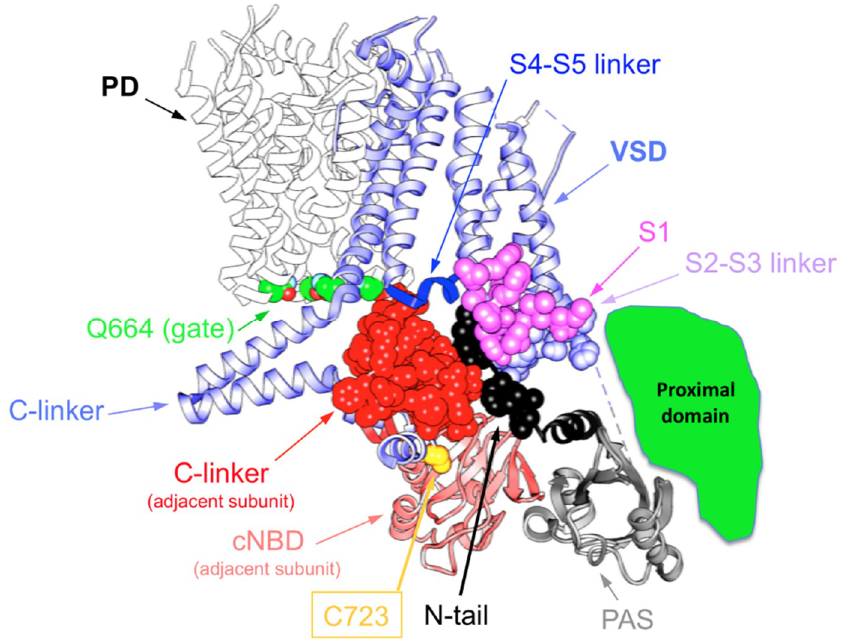
Figure 5. Extensive network of interactions between Kv11.1 (hERG; PDB: 5VA2) cytoplasmic domains involving several N- and C-terminal regions, plus the S4–S5, S2–S3 and C-linkers, that may dynamically contribute to modulate channel gating. A single VSD is only shown attached to the tetramer of the PD for clarity. The four residues Q664 that mark the place of the cytoplasmic gate at the S6 helix bundle are signaled. Atoms corresponding to the amino terminal N-tail (black), the S2–S3 linker (blue) and the S1 C-terminus of the same subunit (magenta), and the C-linker of the adjacent subunit (red), are shown as spheres. The positions of the PAS domain (grey), the S4–S5 linker (dark blue) and the C-linker of the same subunit, but also the cNBD of the adjacent subunit, are also signaled. Note the position of endogenous cysteine 723, known to establish disulfide bridges with cysteines engineered at the initial residues of the N-tail under different conditions [140,141]. The lower right green area indicates the approximate and speculative location of the proximal domain, that was mostly deleted from the constructs used to obtain the cryo-EM hERG structures.